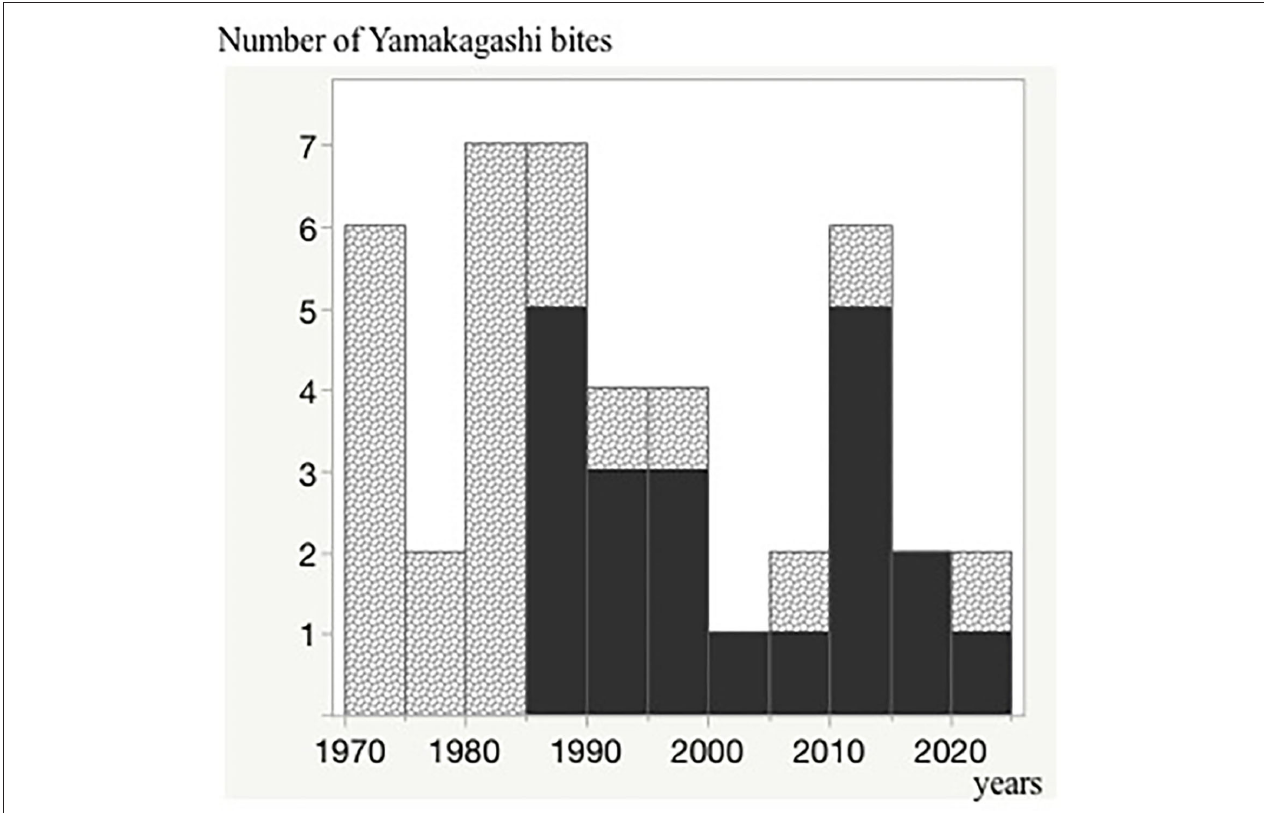
FIGURE 3 | Trends in patients treated with the antivenom over the last 50 years. The black regions indicate the antivenom administrated cases. A single vertical bar indicates a 5-year period (1970–1974, 1975–1979, 1980–1984, 1985–1999, 2000–2004, 2005–2009, 2010–2014, 2015–2019, and 2020). Number of Yamakagashi